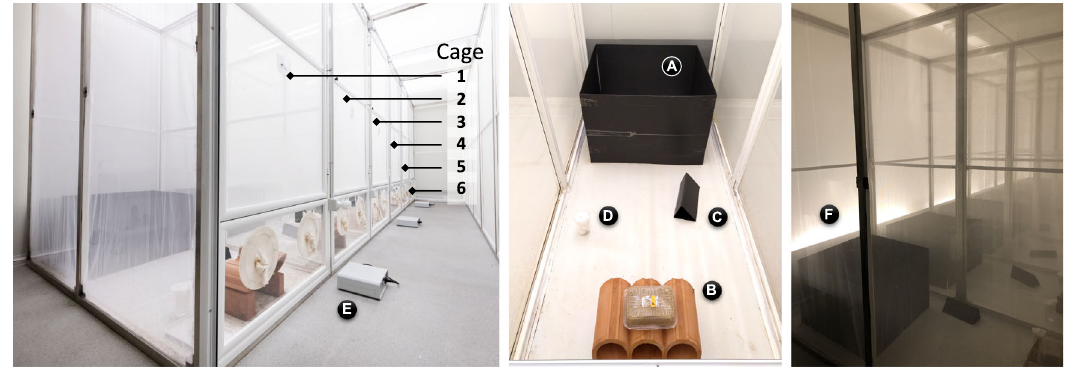
Fig. 1 Design of the large cages used in this study. Images of the six large cages (numbered) within the climatic chamber (left panel) with the typical arrangement (central panel) of the swarming arena ( A ), wet ( B ) and dry ( C ) resting sites and sugar source ( D ). The age-tructured populations in six large cages served as control (cage 1 and 4) or were seeded with low frequency of Ag(QFS)1 (cages 2 and 5) and medium frequency of Ag(QFS)1 (cages 3 and 6). Also shown is the Hemotek feeding system ( E ) and the black horizon marker to emulate sunset ( F , panel on the right). For blood feeding, two Hemotek feeders were introduced in each cage through one of the two openings at the front, leaving the power unit outside. Source: No